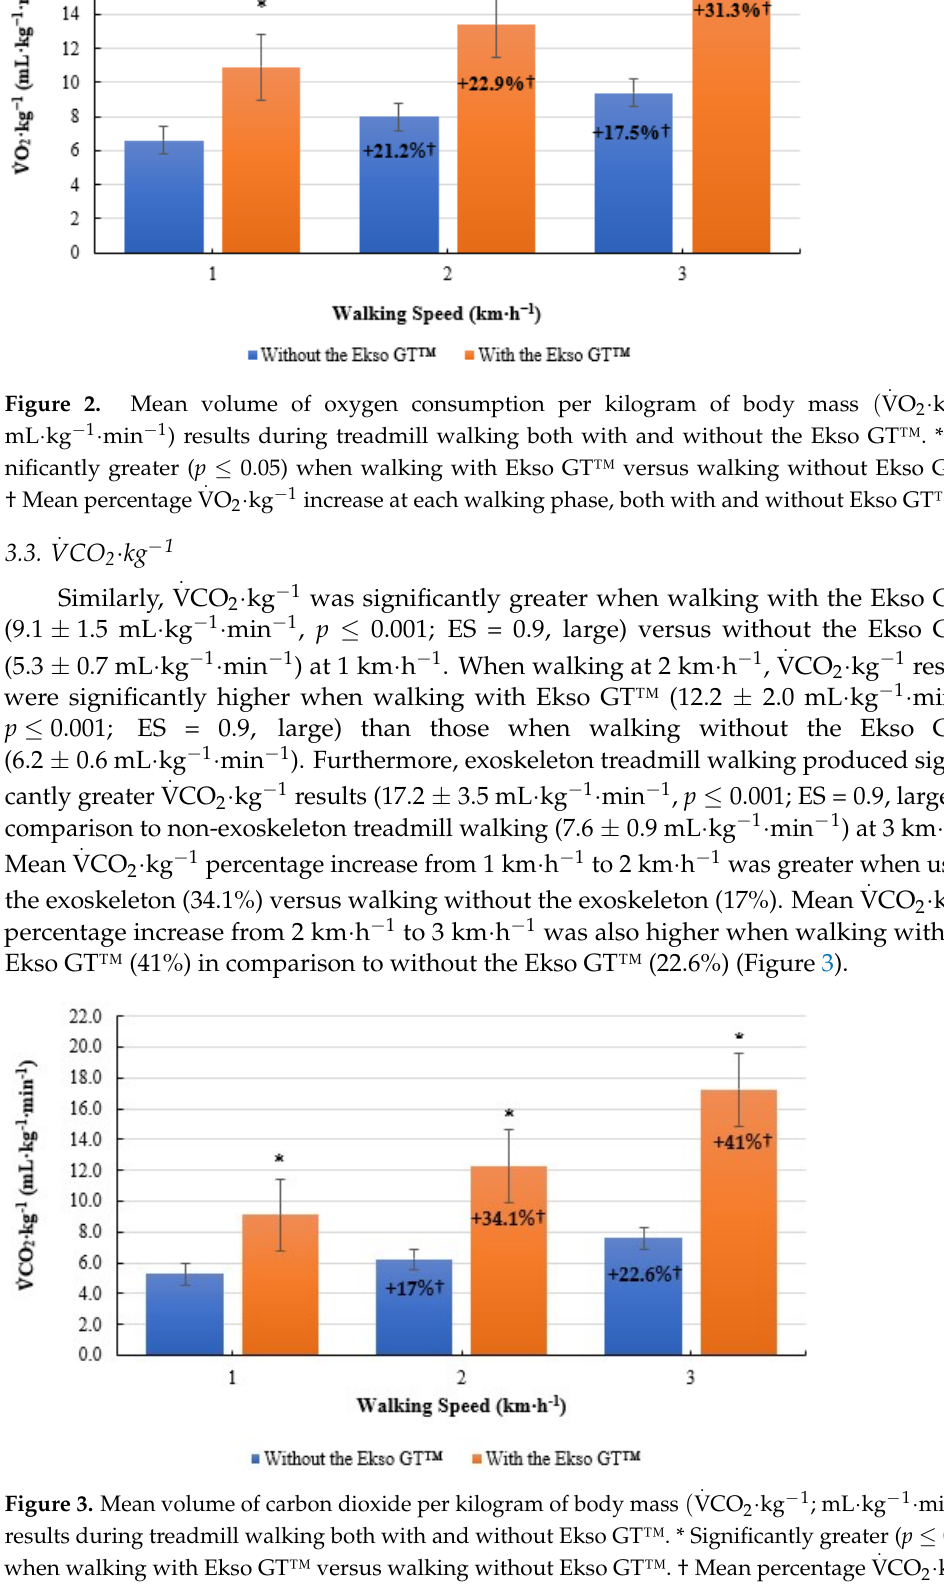
Figure 3. Mean volume of carbon dioxide per kilogram of body mass (V(cid:4662) CO 2 ·kg − 1 ; mL·kg − 1 ·min − 1 ) results during treadmill walking both with and without Ekso GT™. * Significantly greater ( p ≤ 0.05) when walking with Ekso GT™ versus walking without Ekso GT™. † Mean percentage V(cid:4662) CO 2 ·kg − 1 increase at each walking phase, both with and without Ekso GT™.